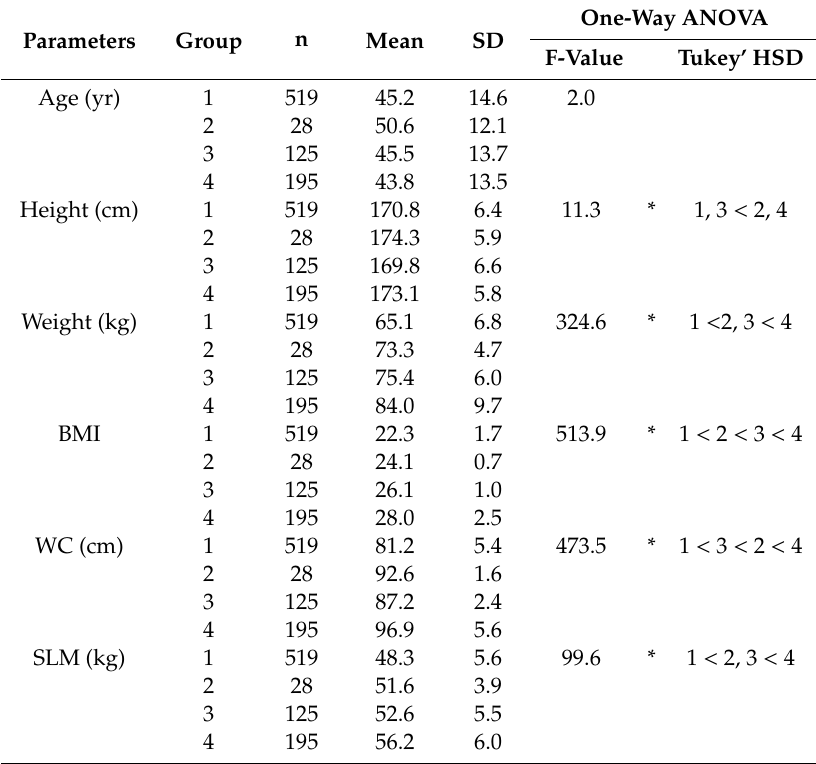
Table 1. The physical characteristics for the four